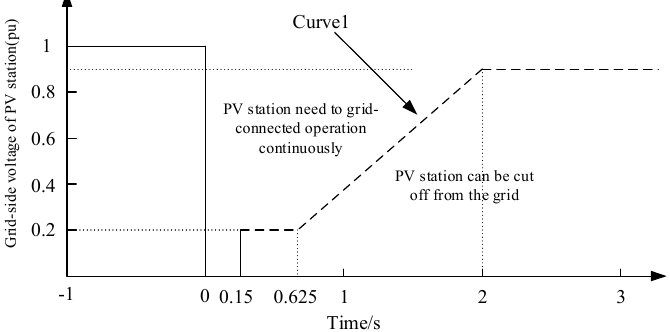
Figure 1. The requirement of low voltage ride through (LVRT) for photovoltaic (PV) power plants.